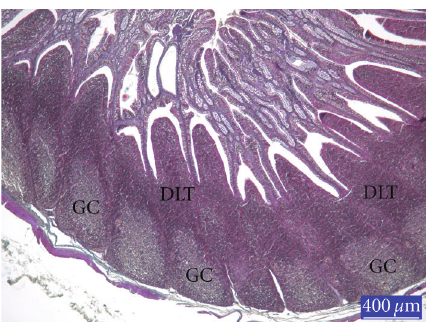
Figure 1: Section from the sacculus rotundus (SR) of rabbits from control group, GC: germinal center, DLT: di ff use lymphoid tissue, trichrome staining.